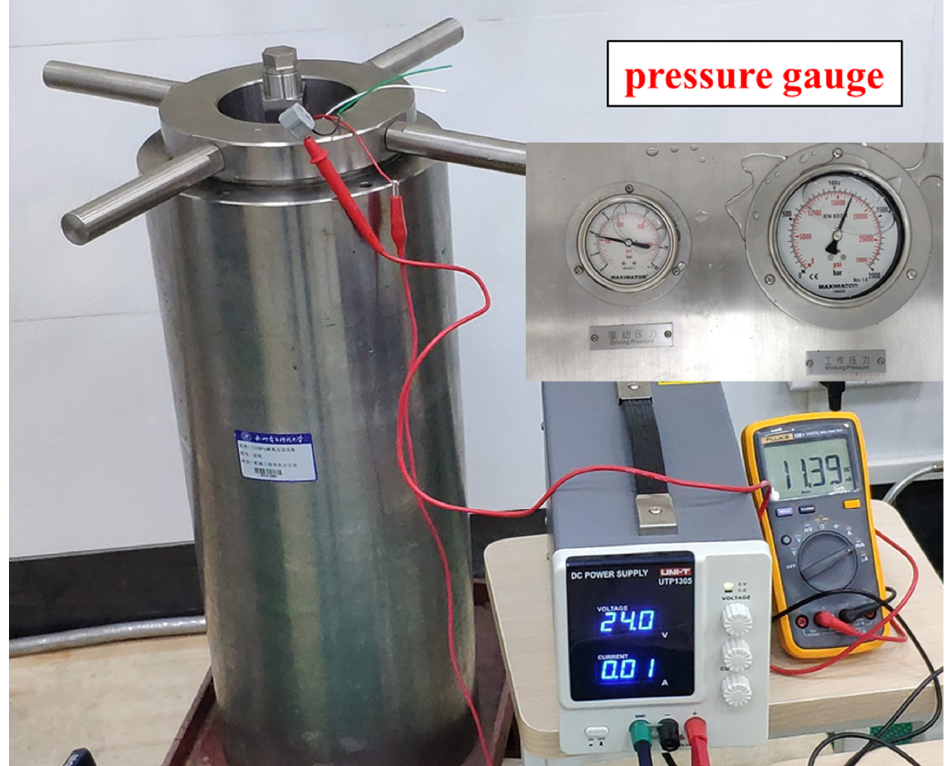
Figure 7. Pressure test of circuit board. (We first increase the pressure to 10% of the maximum test pressure, then gradually increase the test pressure by 10% each time until reaching maximum test pressure. Then, we hold the pressure for a period of time (approximately 30 min), after which, we reduce the pressure to 87% of the maximum test pressure and continue holding pressure. If there are no abnormalities throughout the process, the part is considered to meet the requirements for high-pressure operation. The circuit board is connected to the DC constant voltage power supply (24 V) through the waterproof connector. Then, the circuit board is put into the high-pressure tank filled with oil for testing, and the container is pressurized with a pneumatic booster. It can be seen from the indication of the pressure gauge that the highest pressure has reached 110 MPa, which is 107% of the working pressure. The pressure test process is strictly in accordance with the standard of the high voltage test, and there is no abnormality in the circuit board signal transmission during the test. This proves that the special circuit board of this device can be used in a high voltage environment. Similarly, the temperature sensor and pressure sensor of this device were tested in this way, and the test results show that these components can work normally under high